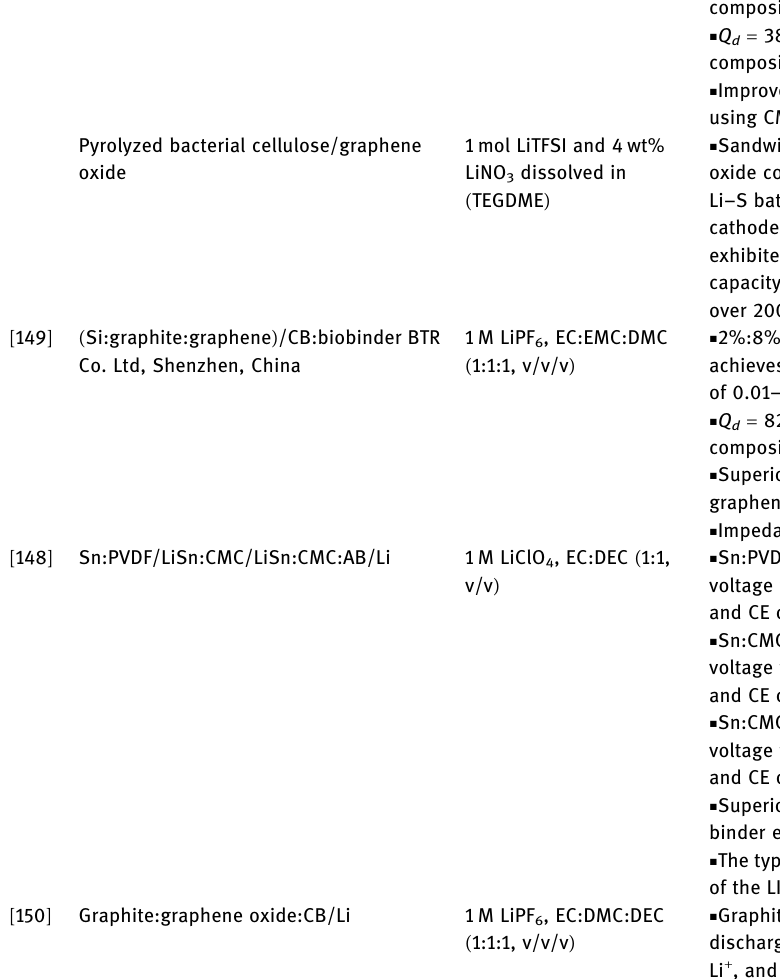
▪ Graphite:graphene vs roman in table